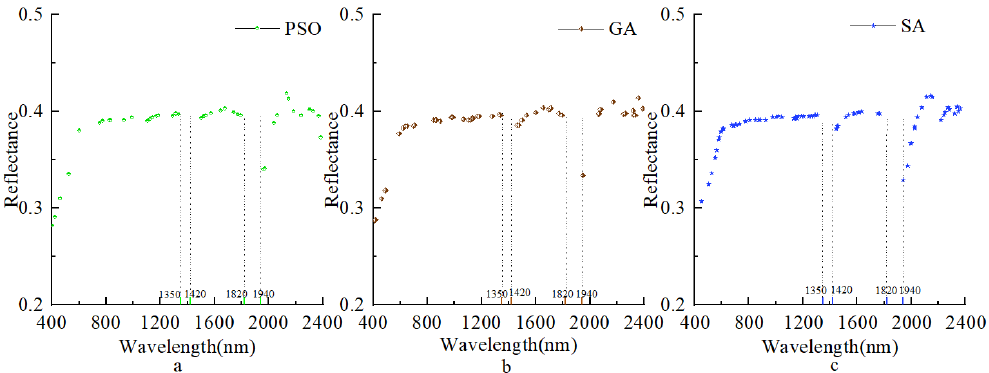
Figure 4. Result of PSO, GA, SA characteristic wavelength